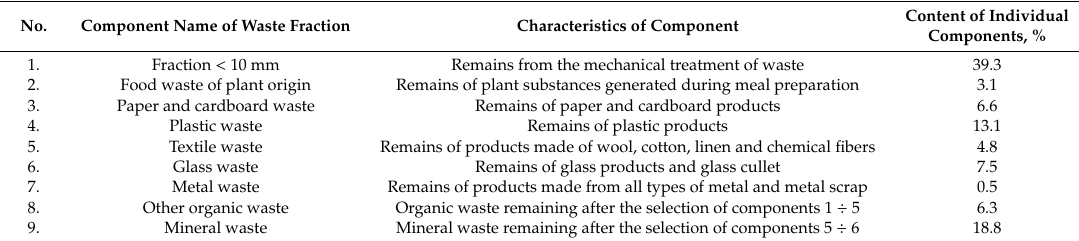
Table 1. Morphological composition of